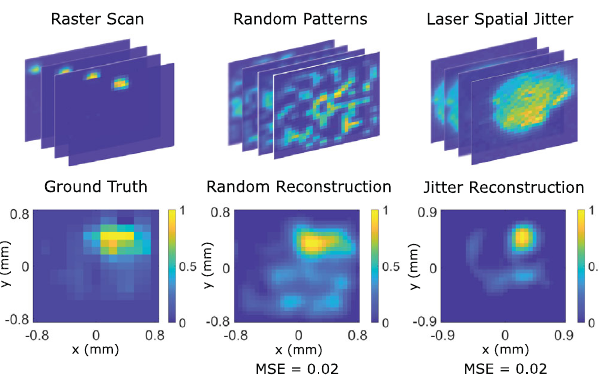
FIG. 4. QE map reconstructions. The top row shows example laser profiles used to generate the QE maps seen on the bottom row. Left: Ground truth QE map obtained by raster scan. Middle: reconstruction using the random mask dataset. Right: reconstruction using the jitter dataset. The random and jitter datasets successfully reconstruct the hot spot seen in the upper right corner of the ground truth.